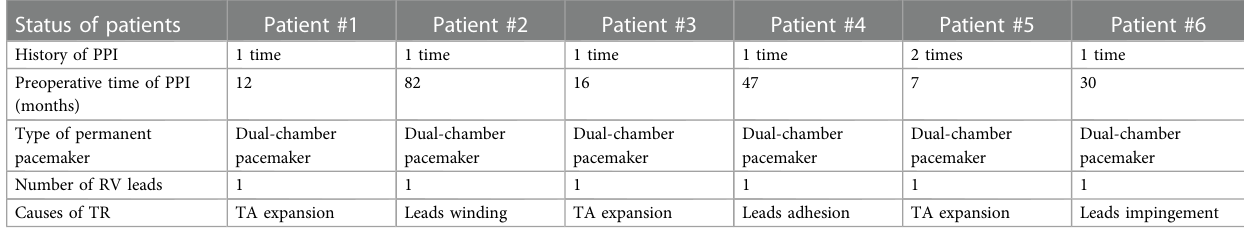
TABLE 2 Status and management of leads in patients with a transvenous pacing system who underwent TTVR.